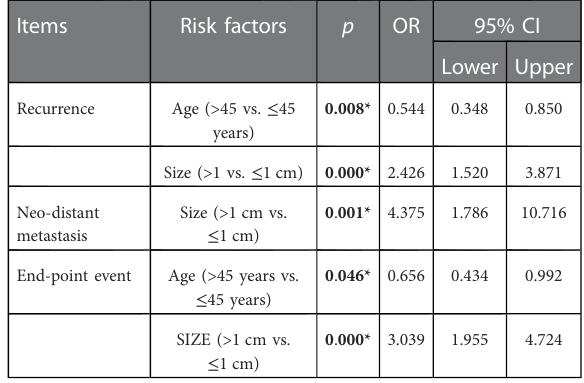
TABLE 3 Multivariate analyses for recurrence and/or neo-distant metastasis.